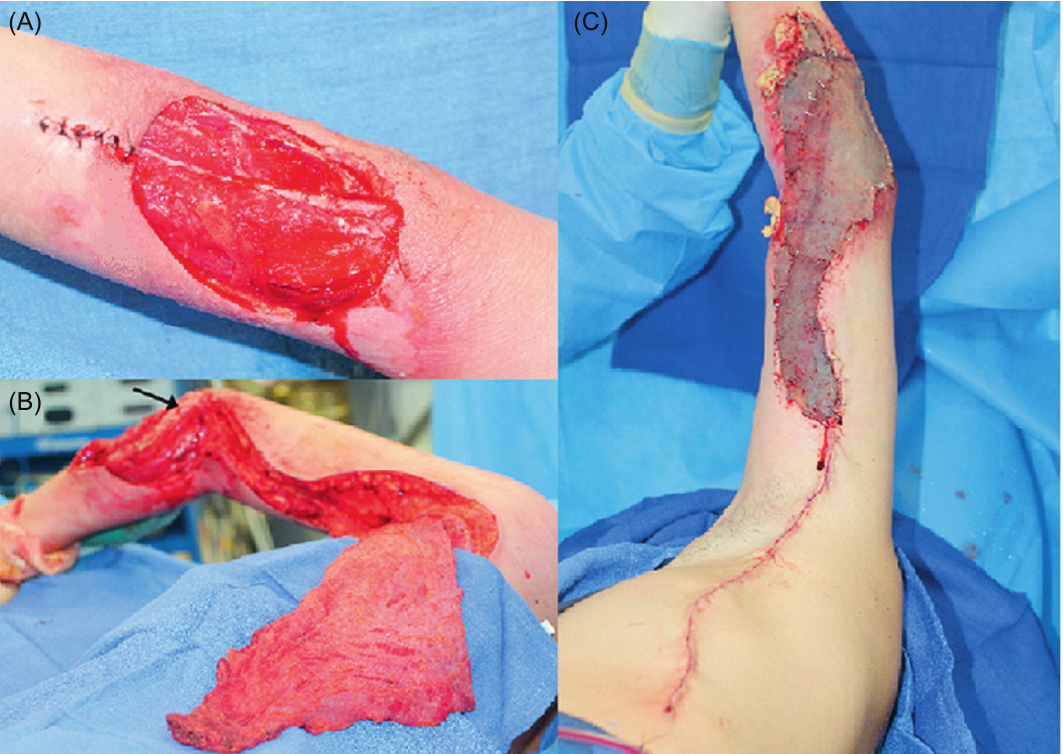
Figure 1. (A) Excised malignant fibrous histiocytoma requiring resection of soft tissue including the periosteum of the radial bone segment. Margins were negative and defined as wide [8, 9]. (B) Pedicled latissimus dorsi muscle flap prepared for functional muscle transfer: its humeral attachment and thoracodorsal neurovascular bundle were preserved. (C) The distal part of the flap was attached with through-and- through sutures to the proximal radial bone cortex and skin grafted for external coverage. Subsequent flap fixation to the bone (the site of musculodesis is marked by the arrow) allowed its use as a neo-elbow extending unit.